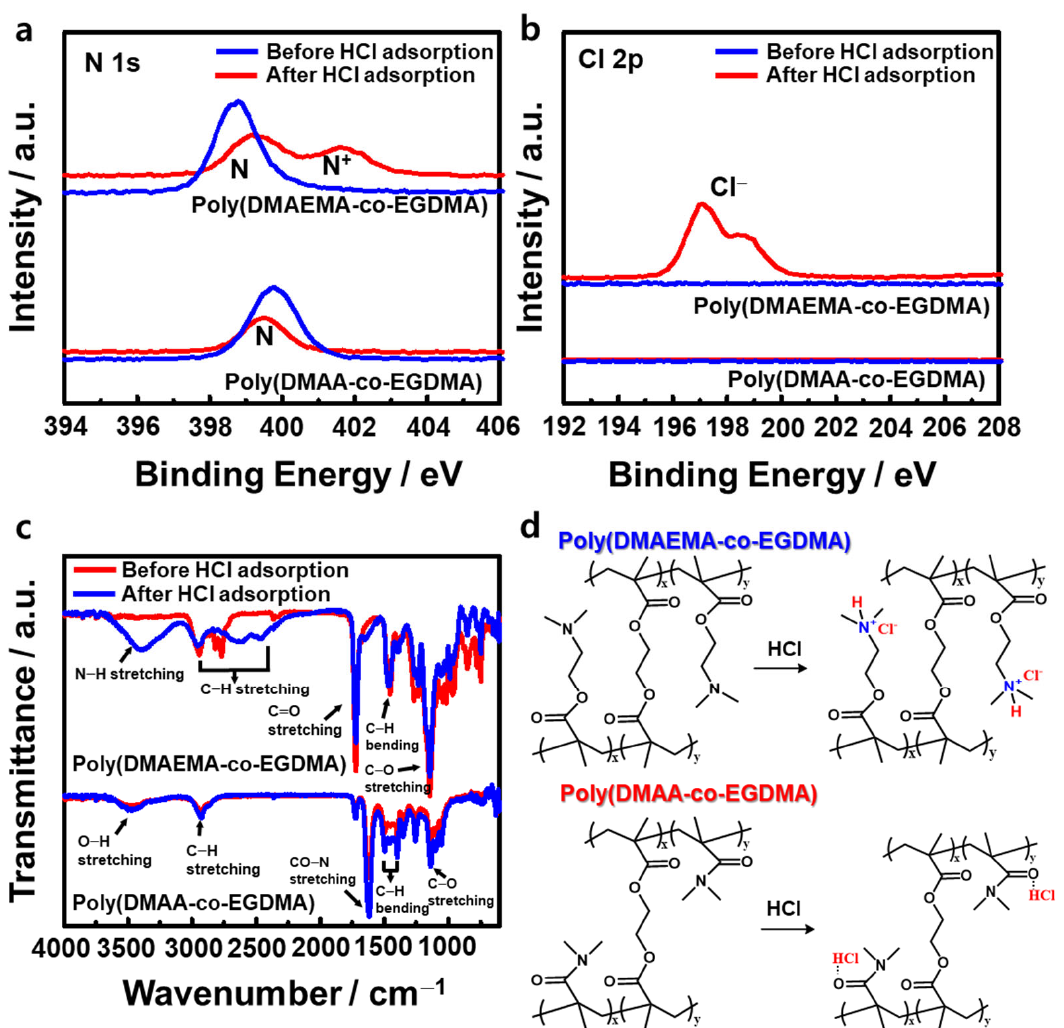
Figure 3. ( a , b ) High-resolution X-ray photoelectron spectra for ( a ) N 1s and ( b ) Cl 2p on poly(DMAEMA-co-EGDMA) and poly(DMAA-co-EGDMA) films before and after HCl adsorption and ( c ) Fourier transform infrared spectra for poly(DMAEMA-co-EGDMA) and poly(DMAA-co-EGDMA) films before and after HCl adsorption. ( d ) Predicted HCl adsorption mechanism on poly(DMAEMA- co-EGDMA) and poly(DMAA-co-EGDMA)